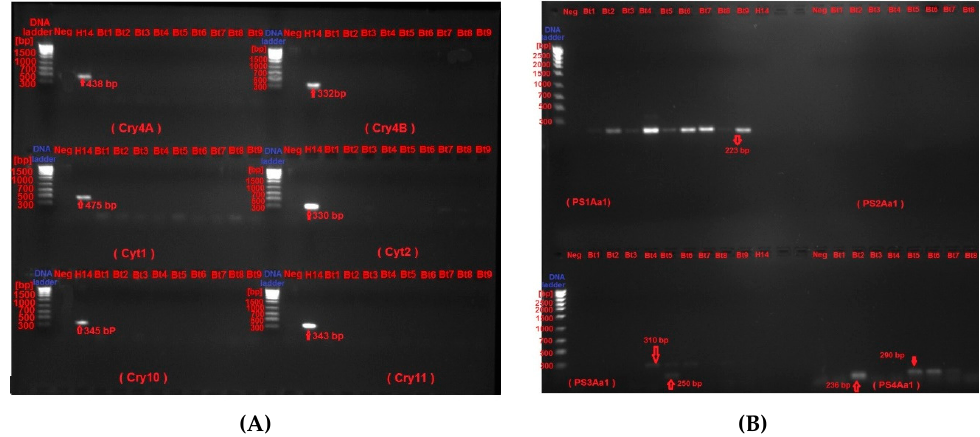
Figure 3. Polymerase chain reaction screening of Bt isolates for a panel of Cry , Cyt and PS genes. PCR reactions were conducted as described in Materials and Methods section. Amplicons were run at 100 v for 30 min in 2% agarose gels pre-stained with ethidium bromide and examined with a charge-coupled device (CCD) camera mounted on a UVITC gel documentation system. Standard DNA marker was included in lane 1 to identify band sizes. ( A ) PCR of four Cry (4A, 4B, 10 and 11) Cyt (1 and 2) genes. All nine Bt strains were negative for these genes except the reference strain Bacillus thuringiensis subsp. israelensis ( Bti- H14), which were positive for all tested Cry and Cty genes. ( B ) PCR for parasporin genes PS1 , PS2 , PS3 and PS4 . All nine strains were positive for PS1 but negative for the rest. Neg., denotes negative control lane where deionized water was included instead of plasmid DNA